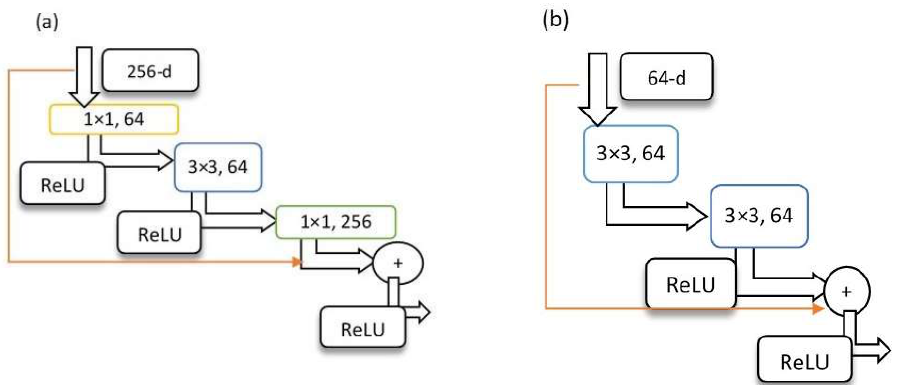
Figure 6. ( a ) ResNet50 model vs. ( b ) ResNet classic model.